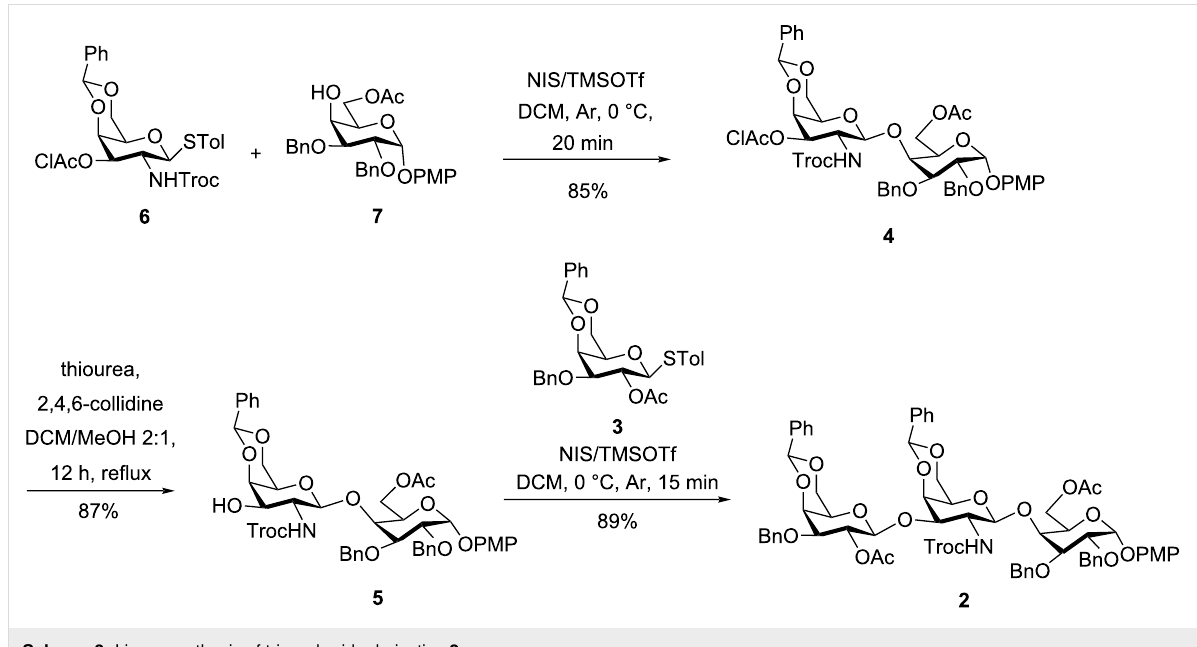
Scheme 3: Linear synthesis of trisaccharide derivative 2 .